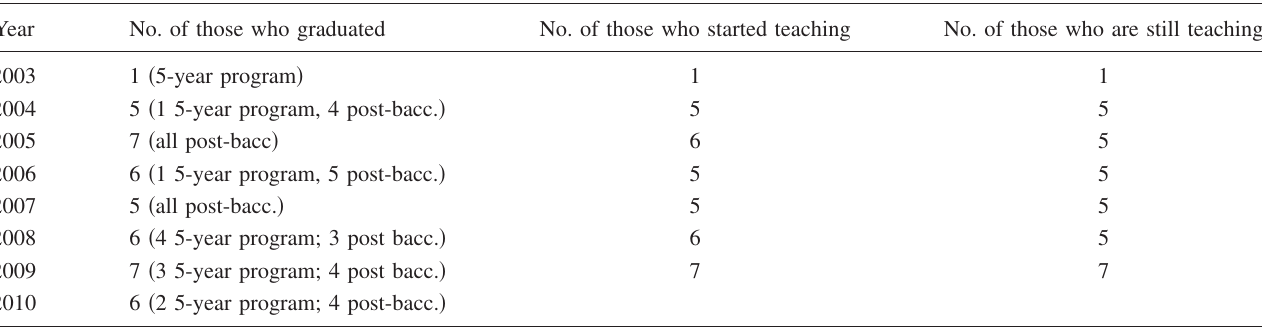
TABLE VII. Graduation, teaching and retention